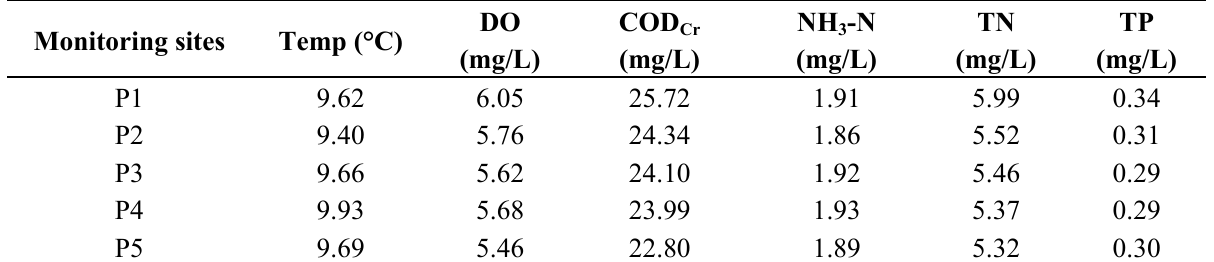
Table 2. Water quality monitoring data of Hongqi River for winter 2009.